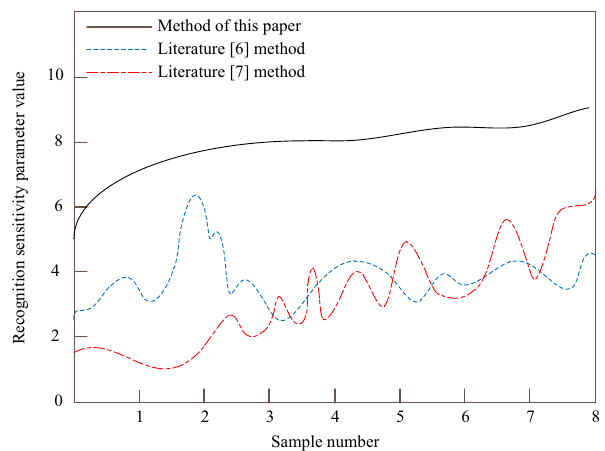
Figure 11: Comparison of recognition sensitivity parameter values.